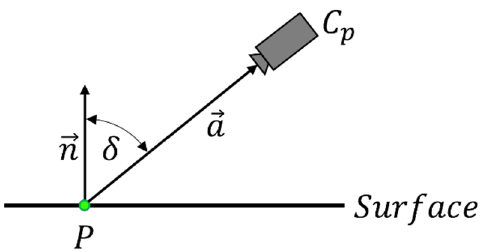
Figure 3. Calculation of the view angle.